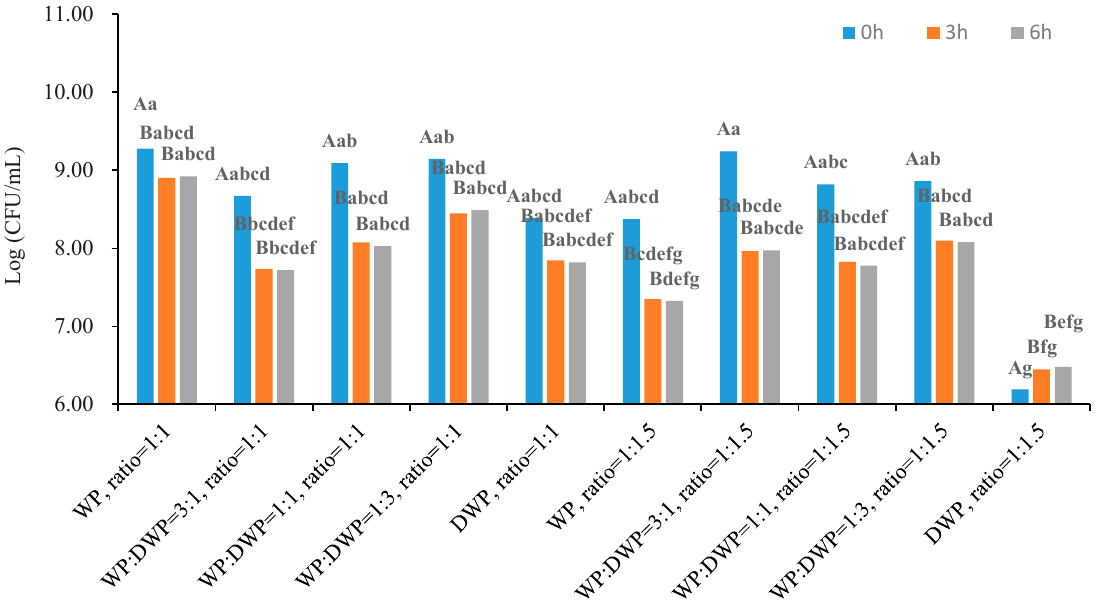
Figure 7. Viability of lyophilized L. plantarum 299v strain with different core-to-wall ratios and formulations after exposure to SIJ for 6 h at 37 °C. WP: whey protein, DWP: denatured whey protein. Superscript letters indicate significant differences ( p < 0.05).